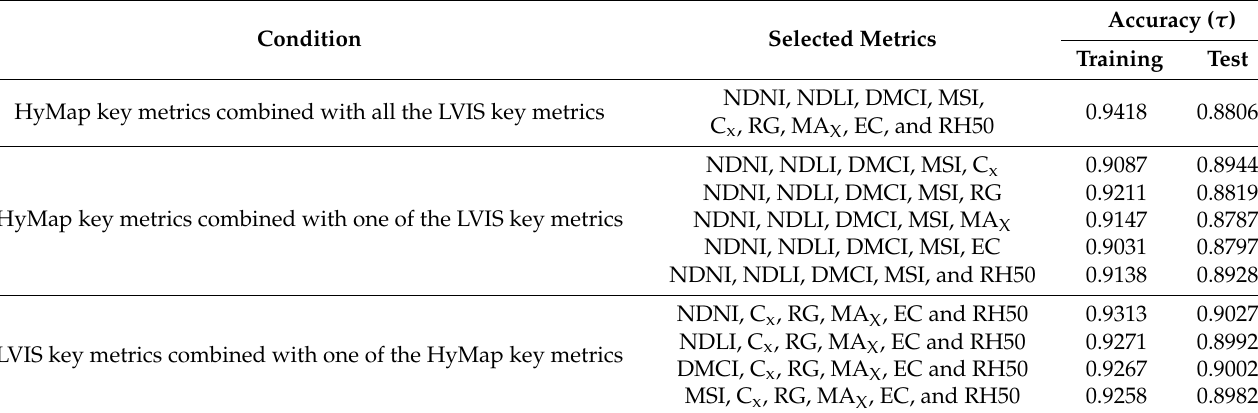
Table 4. HyMap and LVIS key metrics fusion for TDFs age-attribute learning at